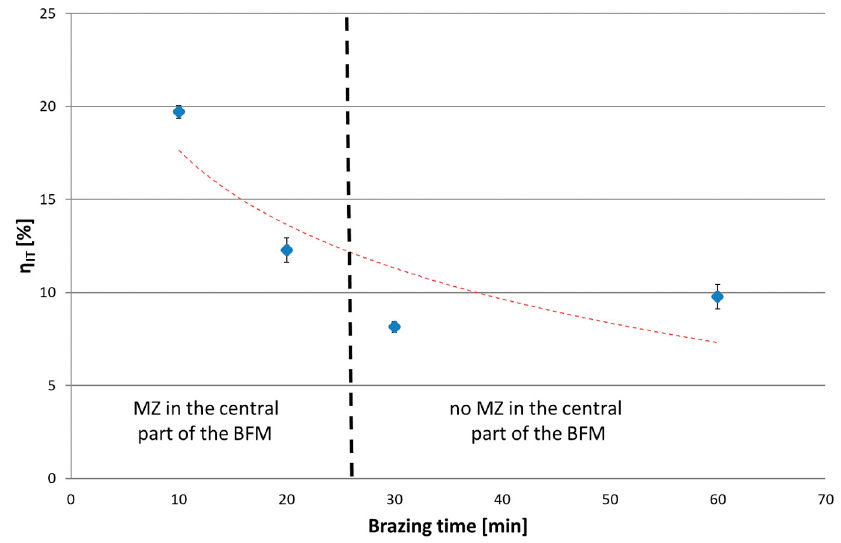
Figure 18. The elastic part of the indentation work for Hastelloy X–Palnicro 36M joints by 1 N load.